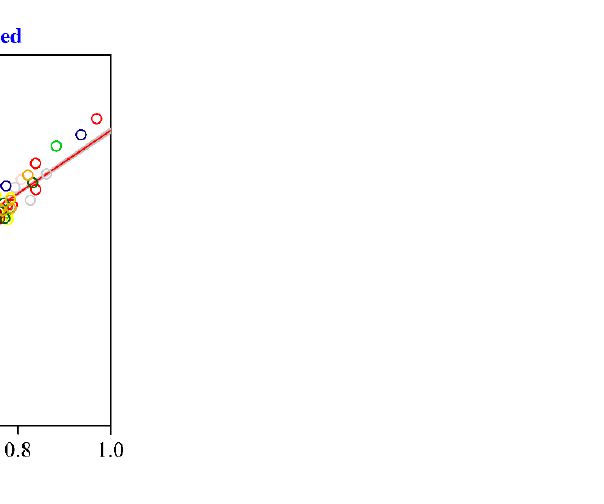
Figure 5. Correlation analysis for the ratio of leaf width to length and the leaf shape fractal dimension. Here, r is the correlation coefficient, and n represents the sample size. Panels ( A − I ) represent different Magnoliaceae species.